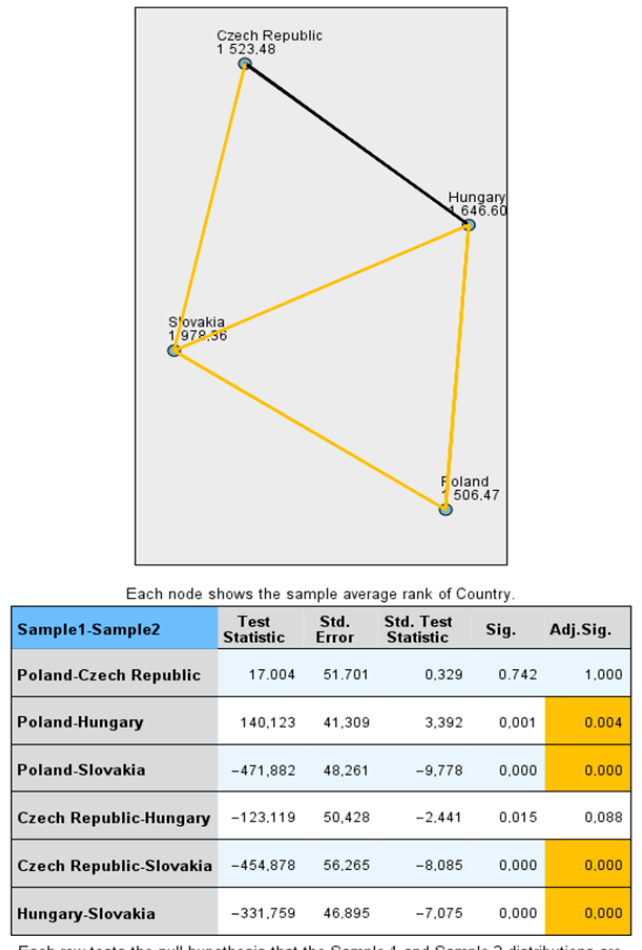
Figure 1. Pairwise Compassions of Country.